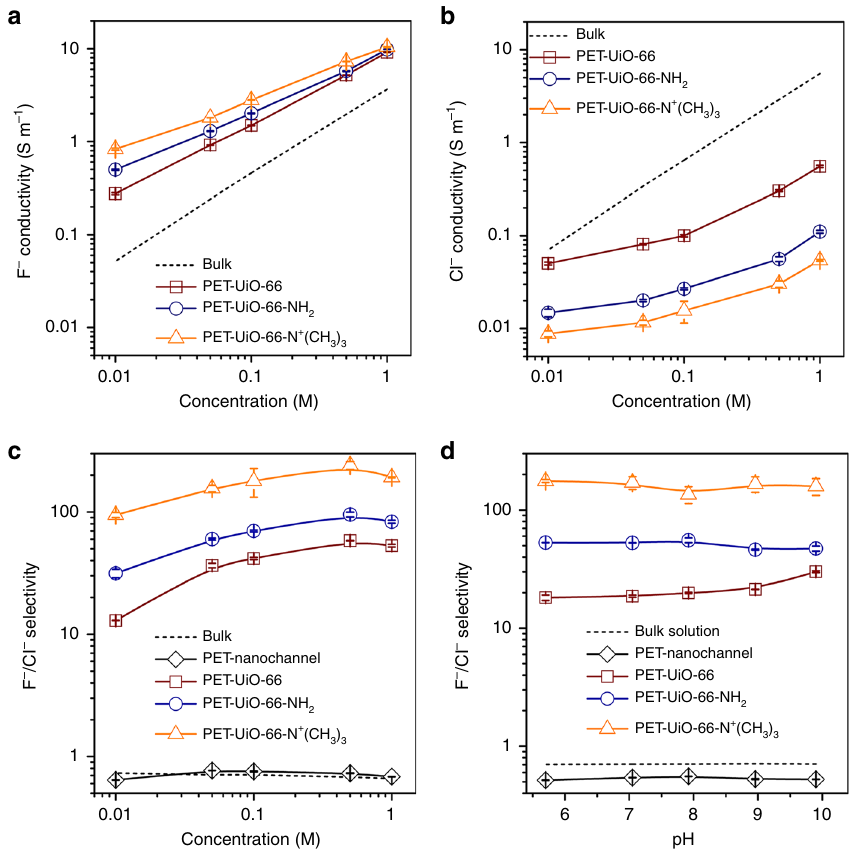
Fig. 5 In fl uence of concentration and pH on F − , Cl − conductivity and F − /Cl − selectivity. a , b F − and Cl − conductivities in PET-UiO-66-X nanochannels as a function of ion concentration. F − conductivities in UiO-66-X nanochannels are much higher than those in bulk solution, while Cl − conductivities in UiO-66- X nanochannels are much lower than those in bulk solution. c F − /Cl − selectivity of PET-UiO-66-X nanochannels as a function of ion concentration. Among the MOFs considered, the UiO-66-N + (CH 3 ) 3 nanochannel exhibits the highest F − /Cl − selectivity (~240). d F − /Cl − selectivity of PET-UiO-66-X nanochannels measured in 0.1 M KF and KCl solutions at different pH values. Error bars represent the standard deviation of three measurements